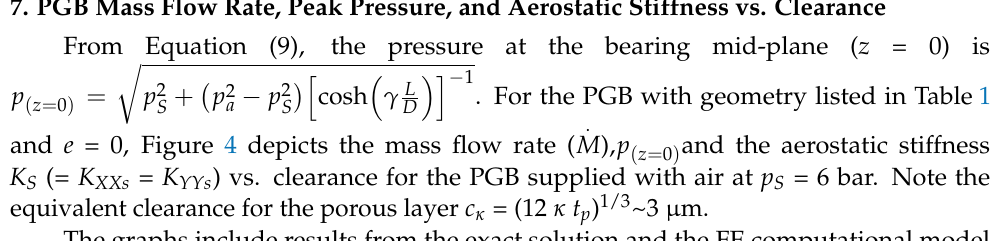
Figure 3. PGB measured mass flow rate